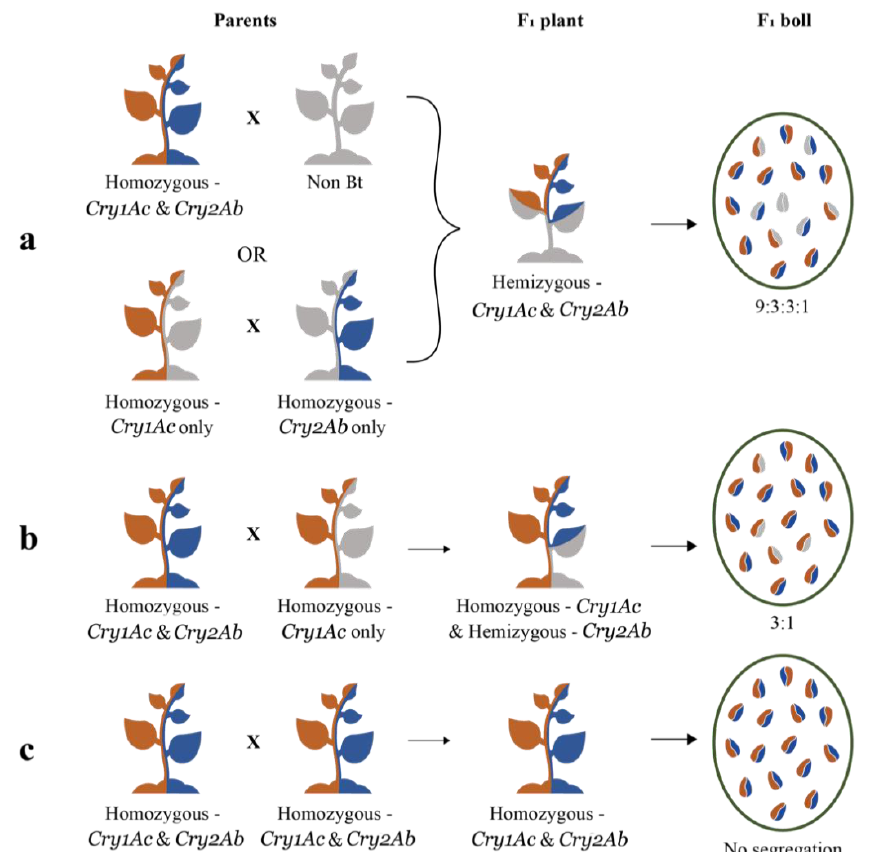
Figure 4. Diagrammatic presentation of the zygosity of Cry genes in the parental lines (Parents), Bt cotton hybrid plants (F 1 plant) and in the seeds occurring in the bolls produced by the hybrid plants (F 1 boll). One half of the plant/seed represents Cry1Ac (orange), while the other half represents Cry2Ab (blue). The absence of any Cry gene is represented by grey colour. The full length of the plant represents homozygosity and half-length represents hemizygosity. ( a ) This represents a condition wherein any of the two different sets of parental lines could combine to produce a hybrid that is hemizygous to the two Cry genes. The seeds in the F 1 boll segregate in the ratio of 9:3:3:1 (di-hybrid ratio). ( b ) This represents a condition where a parental line that is homozygous to the two Cry genes combines with a parent that is homozygous to any one of the Cry genes while lacking the other, to produce an F 1 plant as depicted in the diagram. Here, the seeds in the F 1 boll segregate in the ratio of 3:1 (monohybrid ratio). ( c ) This represents a condition where both parents are homozygous to the two Cry genes, which results in an F 1 plant that is homozygous to the two genes and a non-segregating F 1